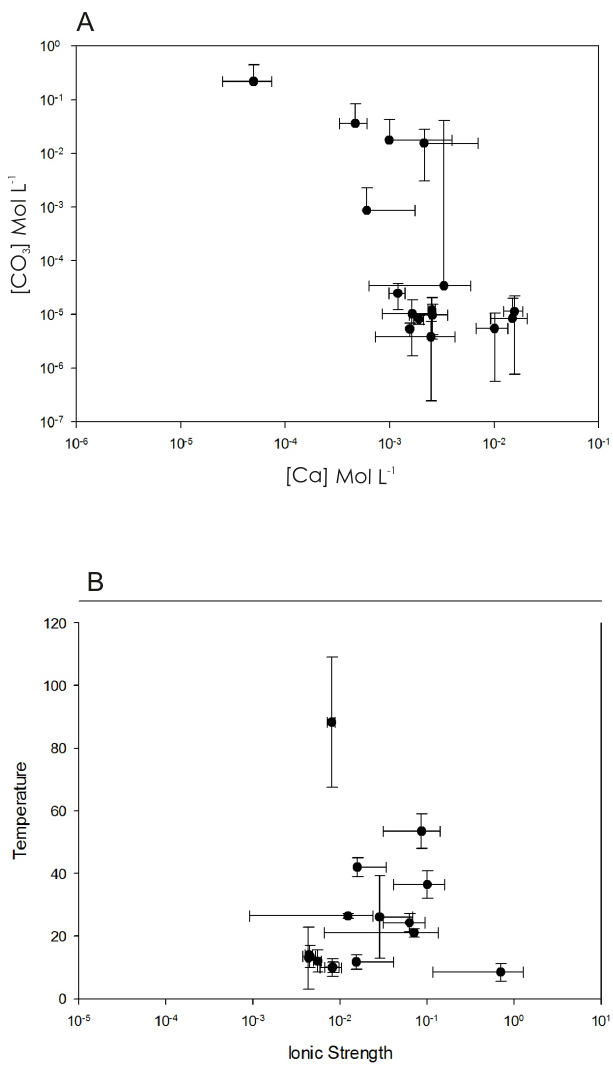
Figure 1. Summary of field data shown in Table 2 (note logarithmic scales). (A) Mean and standard deviation of calcium and carbonate concentrations in molarity. (B) Mean and standard deviation of tem- perature ( ◦ C) and ionic strength (total electron volts dm − 3 ).